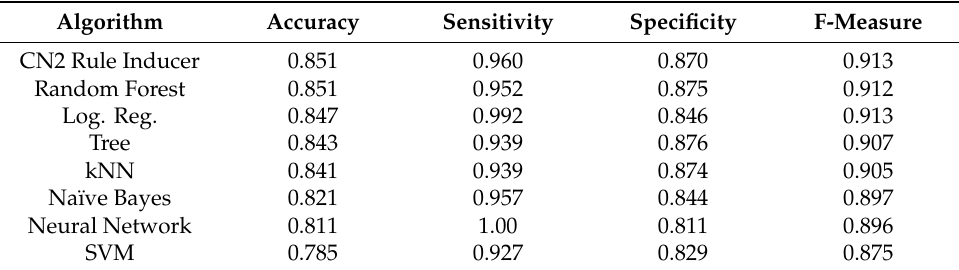
Table 3. Data transformation (none), feature selection (none).